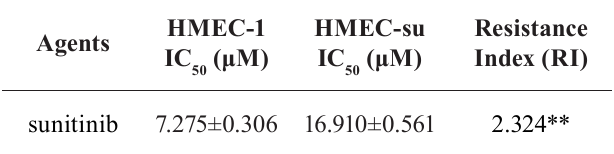
TABLE II - Acquired resistance of endothelial cells to